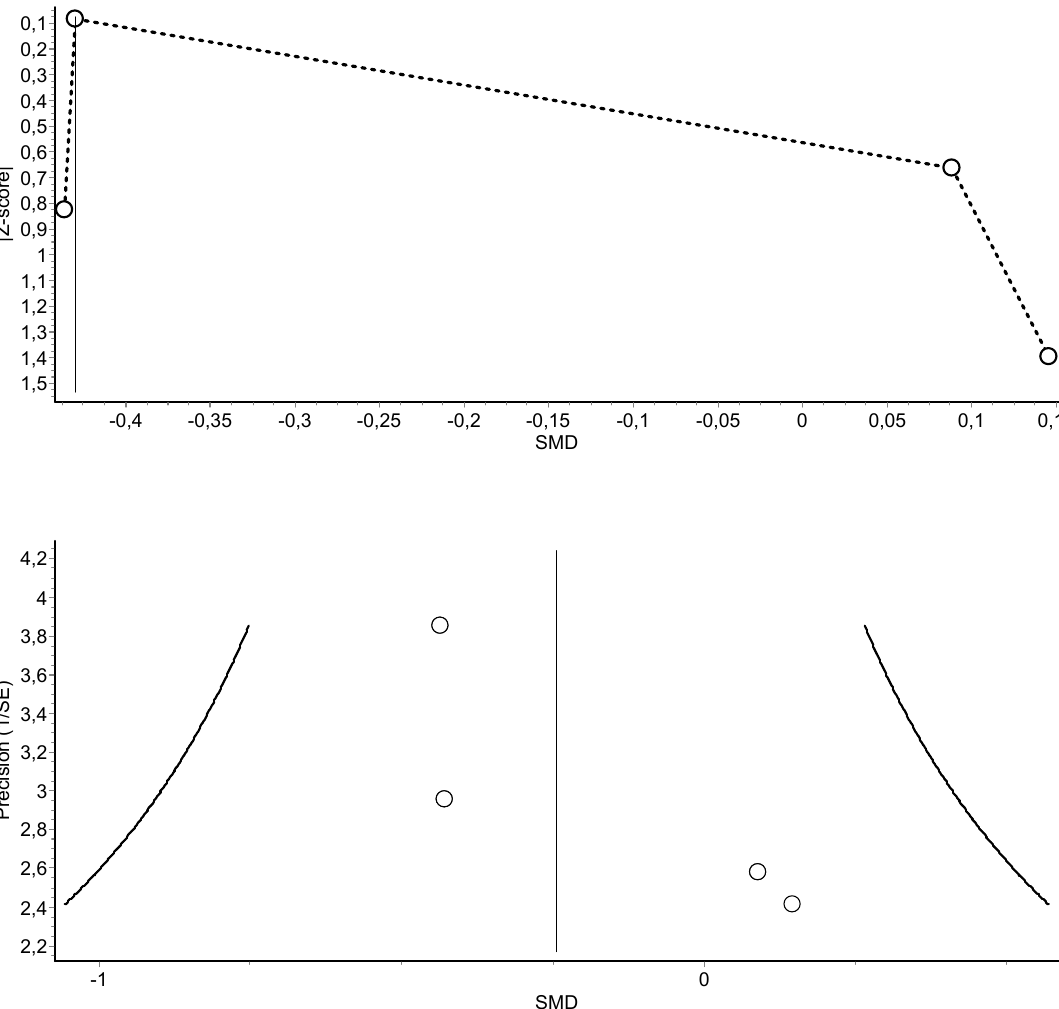
Figure A9. Synthesis funnel and Doi plot (LFK index) for body fat.